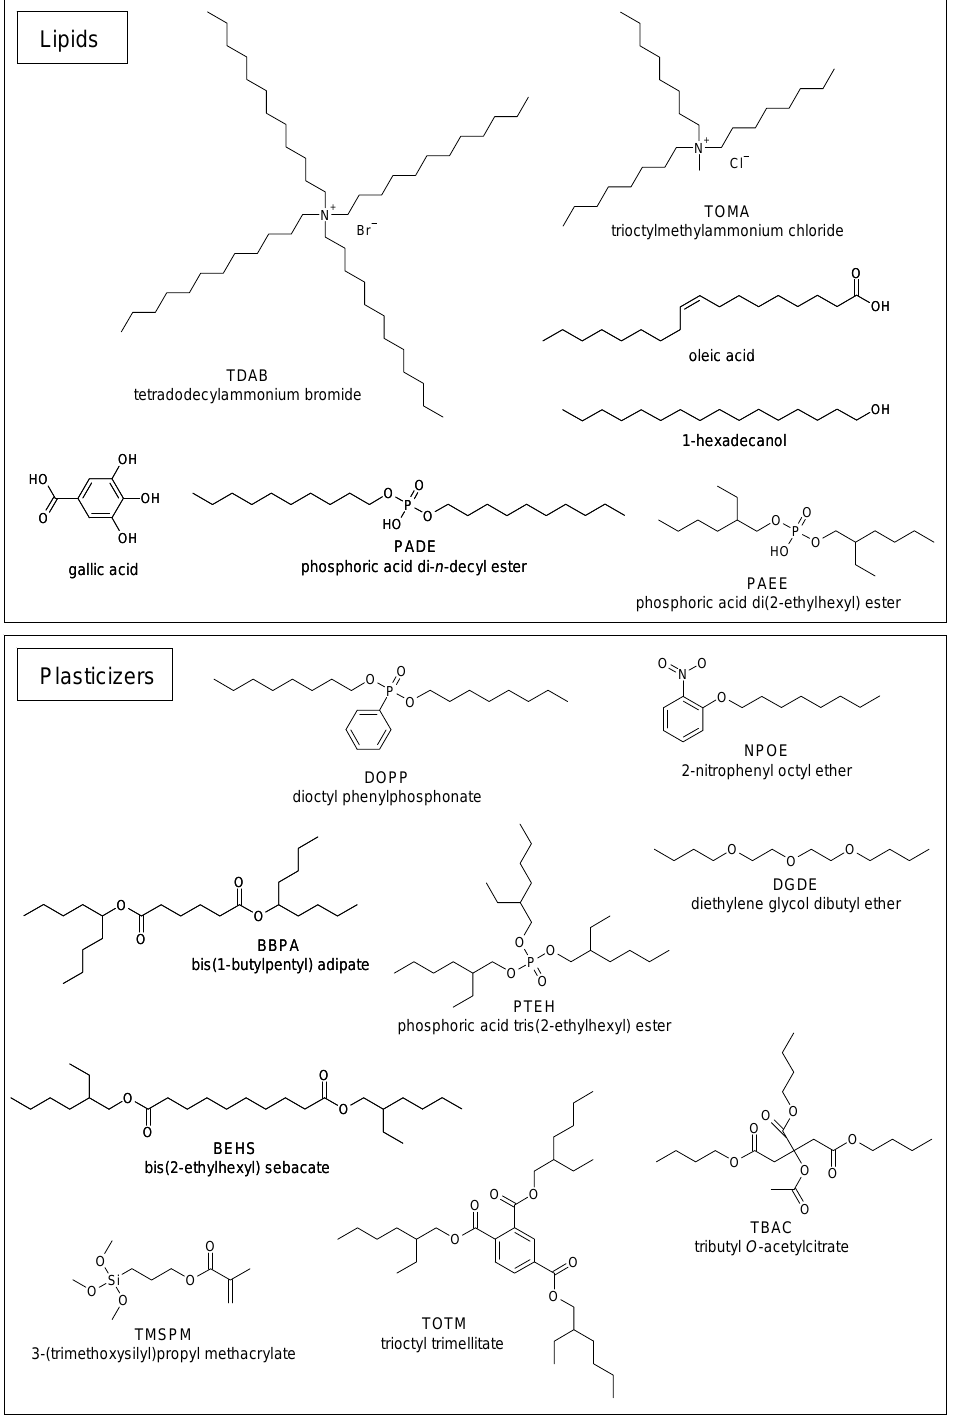
Figure 2. Chemical structures of artificial lipids and plasticizers (Reprinted with permission from the Institute of Electrical Engineers of Japan